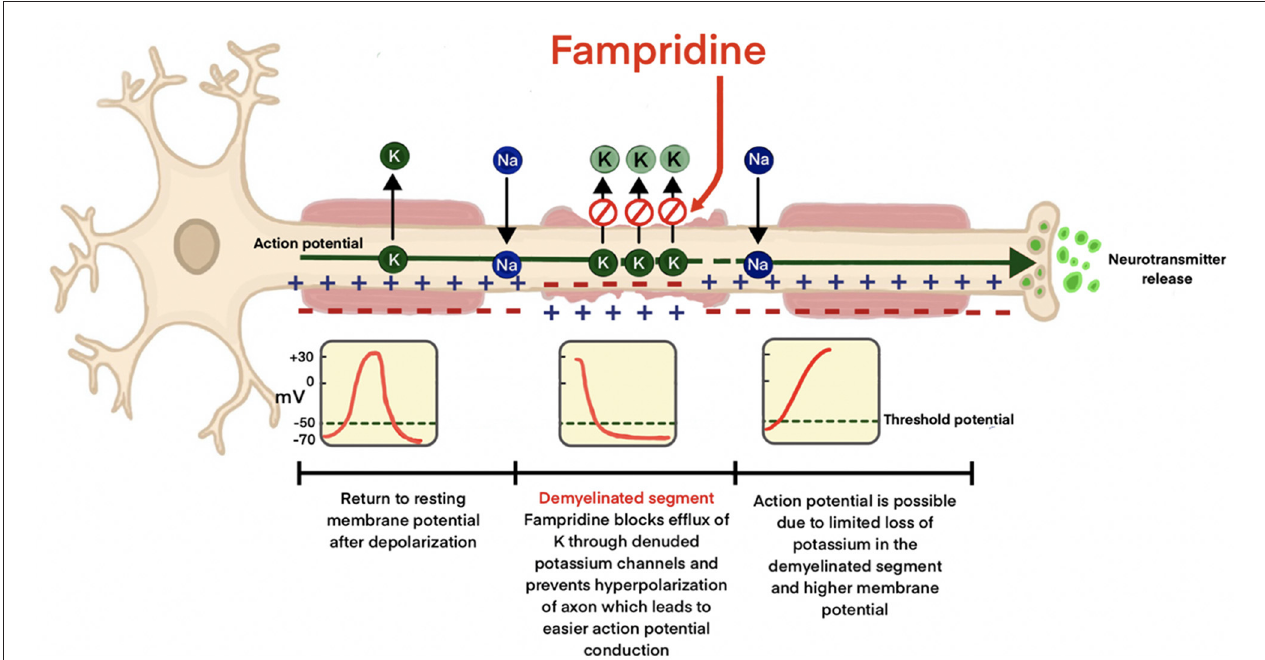
FIGURE 1 | Mechanism of action of Fampridine in demyelinated axons. Potassium efflux from the voltage-gated potassium channels in the denuded axon is prevented, minimizing hyperpolarization leading to improved neural